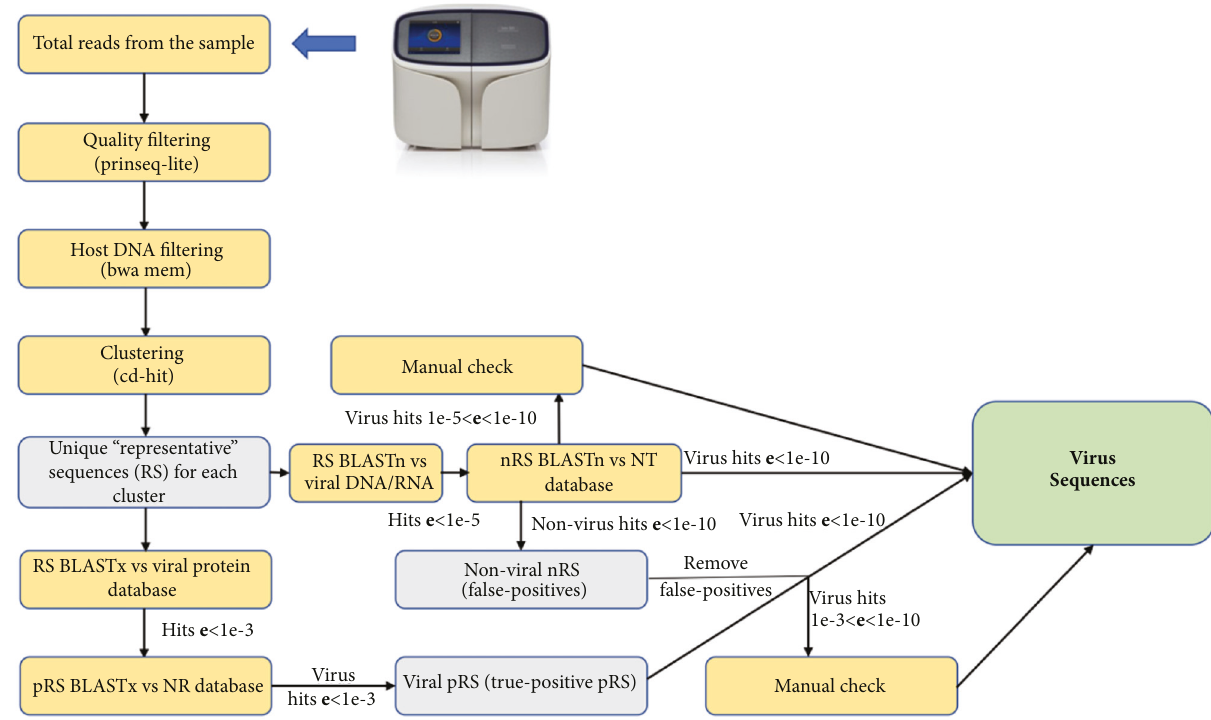
Figure 3: A schematic picture of the bioinformatics pipeline developed for the analysis of the NGS data in this study. Specific third-party tools that were employed are shown in